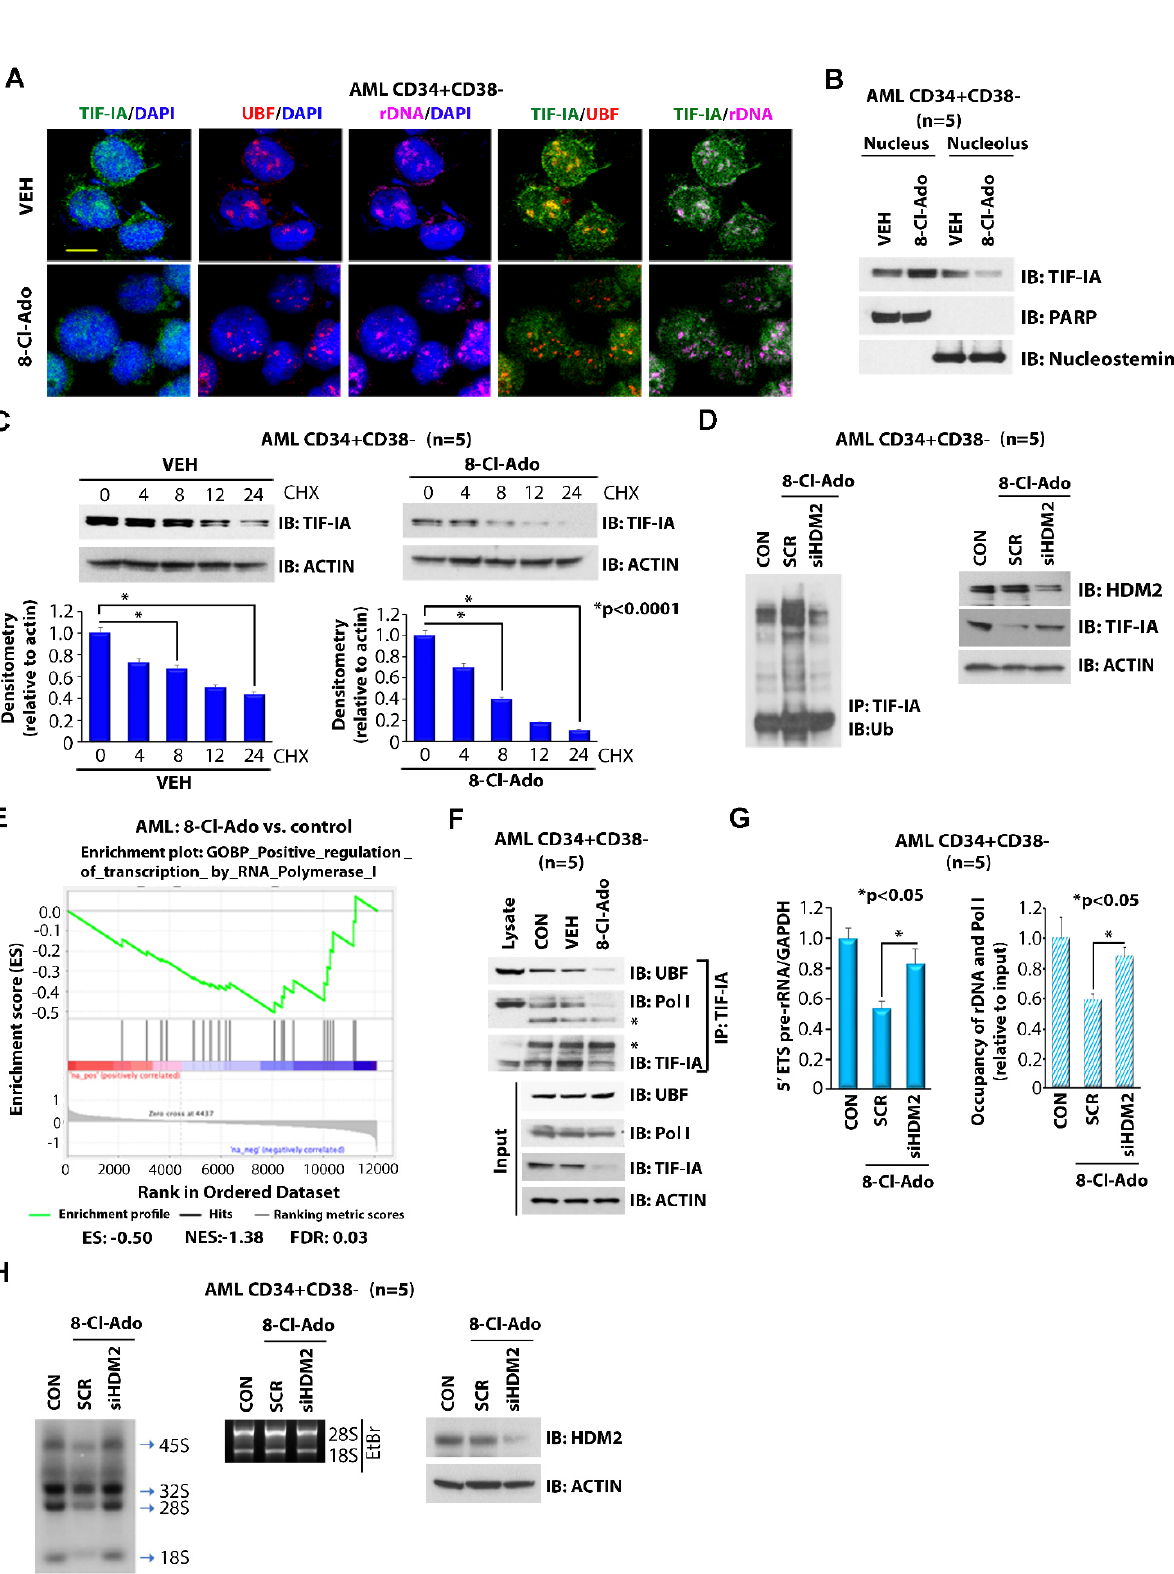
Figure 2. Regulation of TIF-IA expression and function by 8-Cl-Ado. ( A ) Effects of 8-Cl-Ado on cellular distribution of TIF-IA. LSC-enriched blasts were treated with vehicle control (VEH) or 500 nM 8-Cl-Ado for 24 h prior to staining with anti-TIF-IA, anti-UBF antibodies and rDNA probe by immunofluorescence-FISH assay. Images are visualized for TIF-IA, UBF and rDNA using confocal immunofluorescence microscopy. Scale bar, 10 μ m. ( B ) The cells were treated as described in ( A ) and fractionated into nucleus and nucleolus fragments and each lysate was immunoblotted with the indicated antibodies. ( C ) Effect of 8-Cl-Ado on TIF-IA stability. LSC-enriched blasts were treated